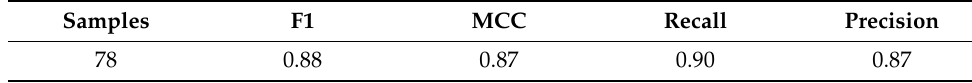
Table 3. Defect detection of PCBs for A0.